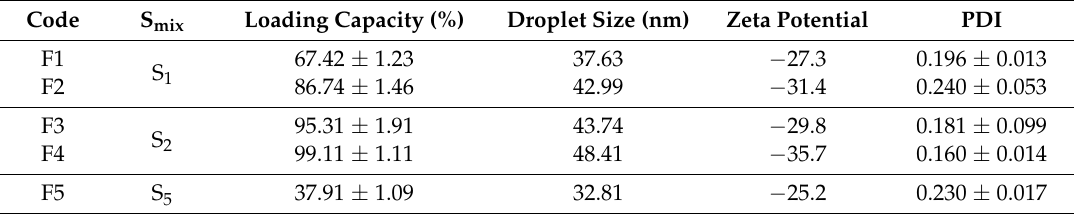
Table 1. Characterization of the prepared EPL- nanoemulsions (NE) formulations.